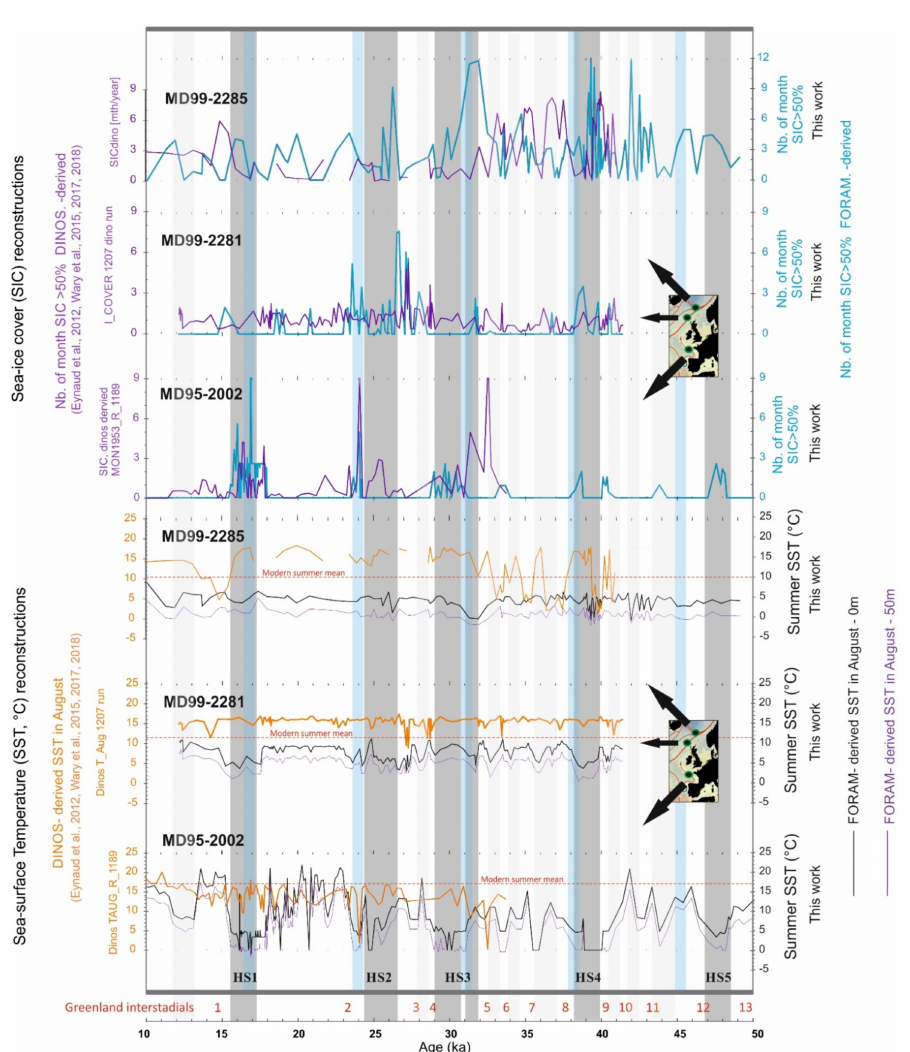
Figure 6. Comparison of reconstructions derived from PF using our new database (August SSTs at 0 and 50 m; SIC durations) with those derived from dinocyst transfer functions (August SSTs; SIC durations) on the same cores for the 50–10 ka interval. Vertical bands position the main cold events as stratigraphically identified in previous Figures, but minor stadials (light grey bands) were here added. The numbers in between correspond to interstadials from the NGRIP stratotype [46,47]. For color used in this figure, the reader is referred to the Web version of this